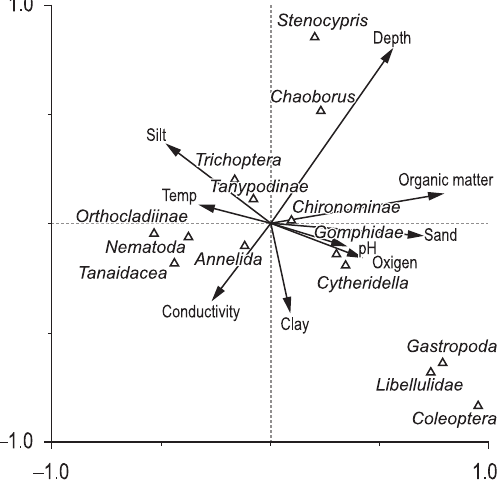
Figure 2. Graphical results of Canonical Correspondence Analysis (CCA) biplot ordination on the basis of the environmental variables and invertebrates community observed in Peri lagoon during the study. The first axis correspond with 36.1% of the explanation of variation, and the second axis with 25.3%.